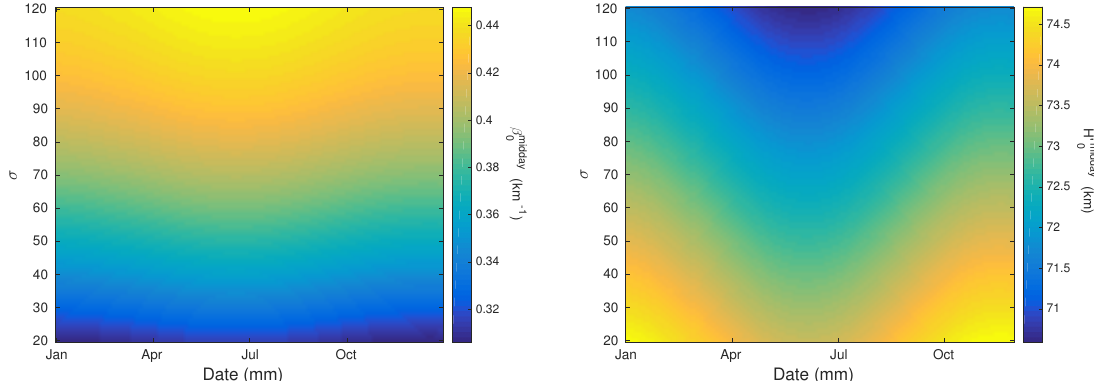
Figure 9. Dependencies of Wait’s parameters in the quiet midday ionosphere, the “sharpness” β midday signal reflection height H (cid:48) 0midday ( right panel ) on season and smoothed daily sunspot number σ